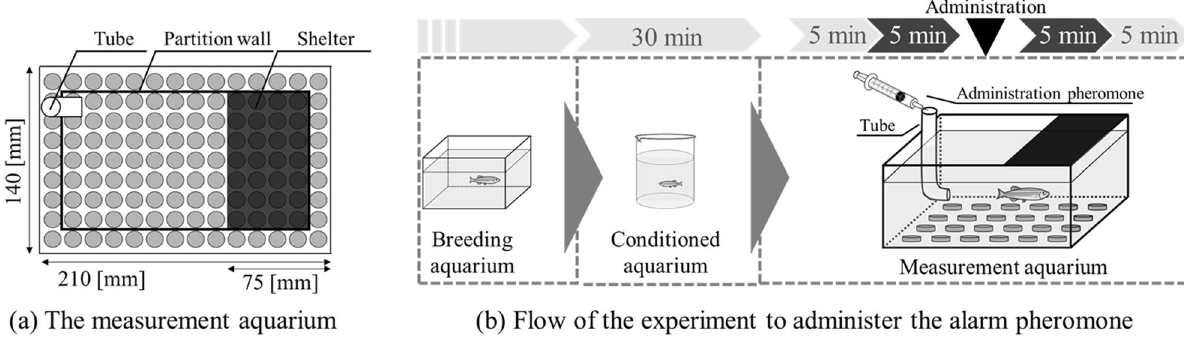
Figure 2. Experimental protocol for exposing the fish to an alarm pheromone. A shelter for hiding and a tube for introducing the substance are installed in the